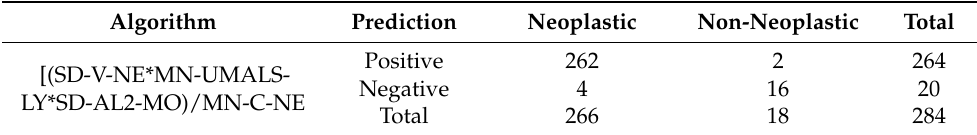
Table 4. Validation of algorithm in distinguishing neoplastic from non-neoplastic cases.